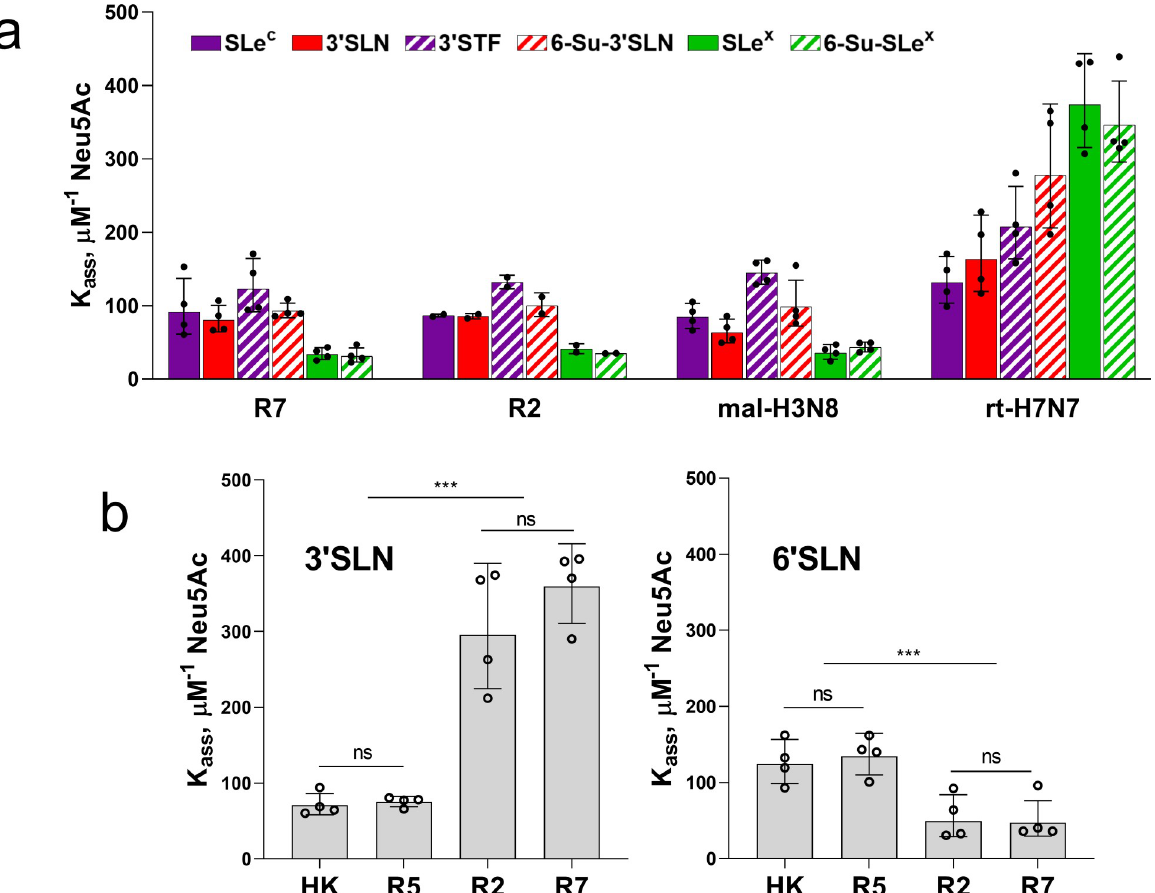
Fig 3. Binding of IAVs to biotinylated SGPs. The solid-phase adsorbed viruses were allowed to bind biotinylated SGPs from solution, and association constants of viral complexes with SGPs (K ass ) were determined as described in Materials and Methods. Higher values of K ass reflect stronger binding. ( a) Binding to six low molecular mass Neu5Ac α 2-3Gal-containing SGPs differing by structure of penultimate sugar moieties. Wild type IAVs A/mallard/Alberta/279/1998 (H3N8) and A/ruddy turnstone/ Delaware/2378/1988 (H7N7) were tested in parallel with R7 and R2. Two to 4 experiments were performed on different days with one replicate for each virus-SGP pair per experiment. ( b) Binding to high molecular mass SGPs 3’SLN and 6’SLN. Two experiments were performed on different days with two replicates per each virus-SGP pair per experiment. All panels show the individual values adjusted for day as described in Materials and Methods with geometric mean (bars) and SDs. P values for the differences between Kass presented in the panel 3a are shown in S3 Table. may predict which avian species perpetuated the precursor of the 1968 pandemic virus. To this end, we determined binding of R7 and R2 to a panel of Neu5Ac α 2-3Gal-containing 20-kDa SGPs. Two representative wild-type viruses, A/mallard/Alberta/279/1998 (H3N8) (mal-H3N8) and A/ruddy turnstone/ Delaware/2378/1988 (H7N7) (rt-H7N7), were used for a comparison (Fig 3a). R7 shared the binding profile with mal-H3N8 which represented typical receptor- binding properties of IAVs in ducks. Similar to other duck viruses [28], R7 and mal-H3N8 bound to fucosylated receptors SLe x and 6-Su-SLe x significantly less efficiently than to non- fucosylated receptors and bound to 3’SLN and its sulfated counterpart 6-Su-3’SLN with similar efficiency. A second control virus, rt-H7N7, displayed receptor-binding characteristics which are often shared by IAVs of Charadriiformes and Galliformes [28,29]. Namely, this virus dis- played the highest binding avidity for fucosylated receptors SLe x and 6-Su-SLe x and bound to 6-Su-3’SLN significantly better than to 3’SLN and SLe c . R7 did not display these features, thus showing no signs of adaptation of the R7 HA to gulls, shorebirds or gallinaceous poultry. The